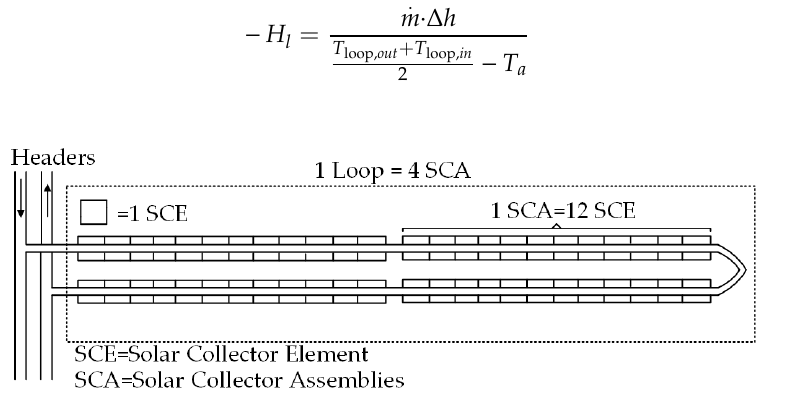
Figure 2. Distribution of collectors in the field.